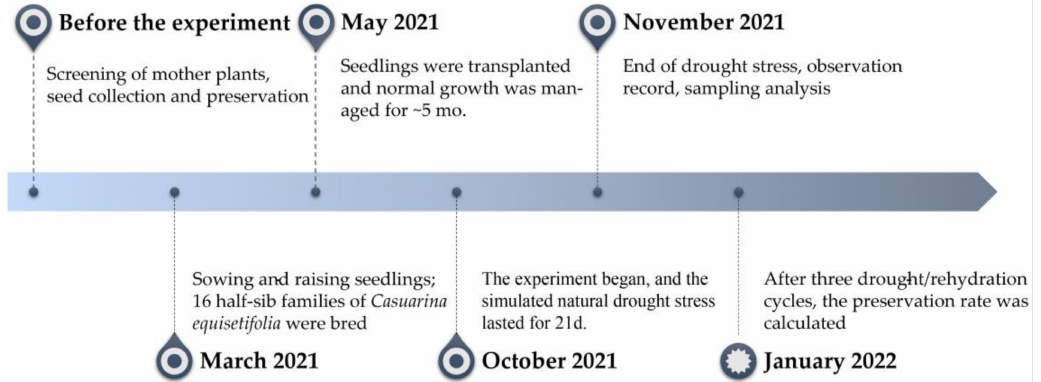
Figure 1. Experimental